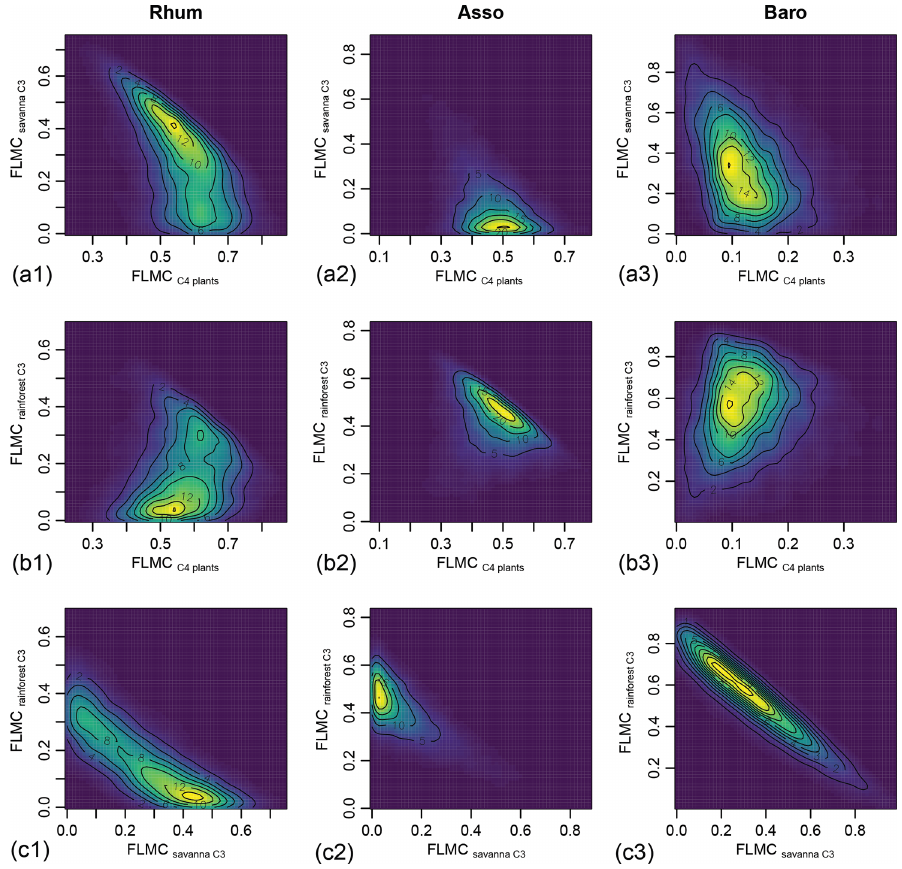
Figure 9. Bivariate density plots of the posterior densities of fractional leaf mass contribution (FLMC) of tropical C 4 plants, savanna C 3 plants, and rainforest C 3 plants in published lake surface sediment samples from